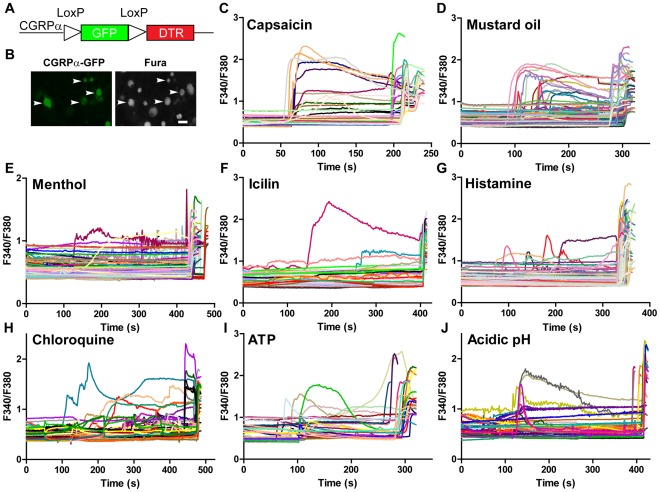
CGRPα-GFP+ DRG neurons respond to agonists that evoke pain and itch sensation.(A) Farnesylated GFP-DTR knocked-in to the start codon of CGRPα. Expression of DTR is conditionally blocked by LoxP flanked GFP and three polyadenylation signals (not shown). LoxP sites are oriented so that the first ATG encountered is in GFP. (B) Representative images of cultured DRG neurons from a CGRPα-GFP+/− mouse after loading with Fura2-AM. Arrows point to CGRPα-GFP+ neurons. (C–J) Responses of CGRPα-GFP+ neurons from heterozygous mice to (C) capsaicin (1 µM), (D) mustard oil (100 µM), (E) menthol (200 µM), (F) icilin (4 µM), (G) histamine (100 µM), (H) chloroquine (1 mM), (I) ATP (100 µM) and (J) acidic pH, followed by stimulation with 100 mM KCl to identify healthy neurons. Scale bar in (B) right panel is 50 µm.